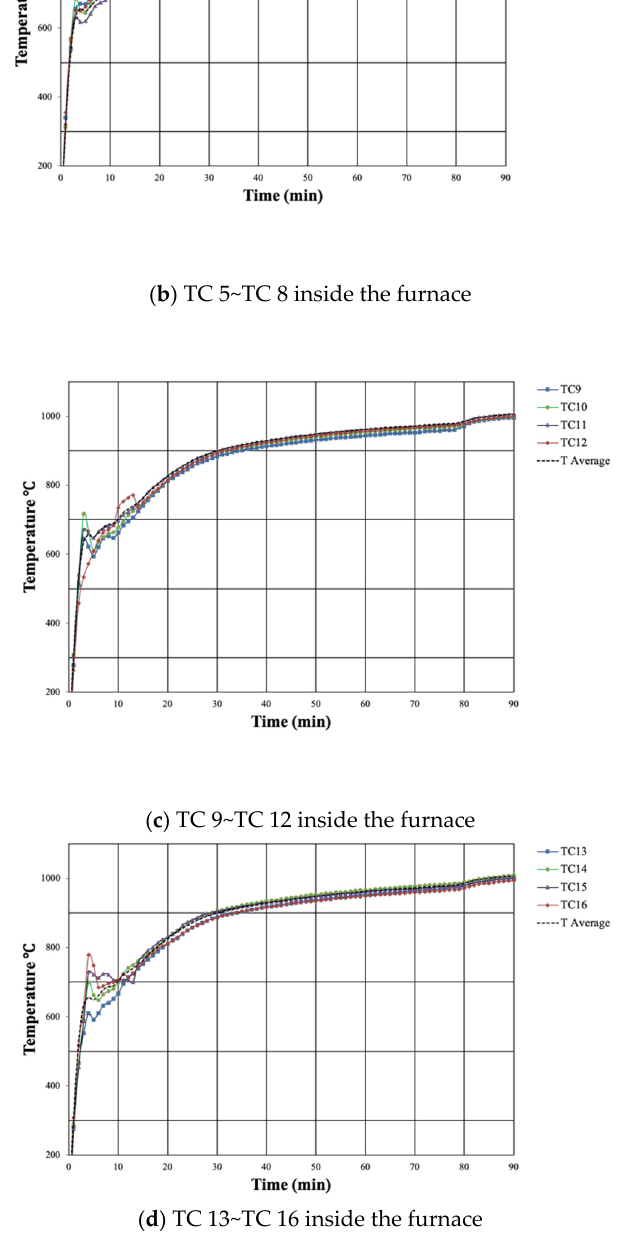
Figure 10. Temperature curves of the measurement points; ( a ) 1–4, ( b ) 5–8, ( c ) 9–12, and ( d ) 13–16 inside the wall/door furnaces; ( e ) 1–3, ( f ) 4–6, ( g ) 7–9 on the unexposed curtain surface. Figure 10e–g shows the heating curves at each measurement point at the top, central, and bottom part of the curtain. Of all the measurement points, point 1 was the closest to the water film output, where the water film only absorbed the minimum heat, so the highest temperature achieved at this position in the experiment was only 45 °C. TC 2 and TC 3 were both similarly covered by the water film, but there were significant differences in